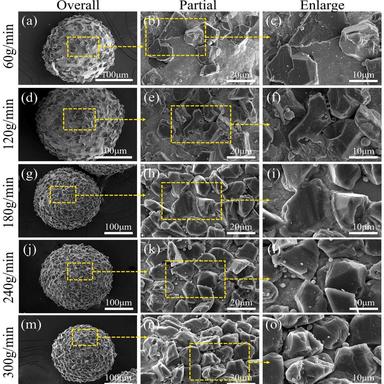
SEM image of the cBN – MAPs: (a)powder flow rate 60 g/min; (b) details of Fig(a); (c) details of Fig(b); (d) powder flow rate 120 g/min; (e) details of Fig(d); (f) details of Fig(e); (g) powder flow rate 180 g/min; (h) details of Fig(g); (i) details of Fig(h); (j) powder flow rate 240 g/min; (k) details of Fig(j); (l) details of Fig(k); (m) powder flow rate 300 g/min; (n) details of Fig(m); (o) details of Fig(n).